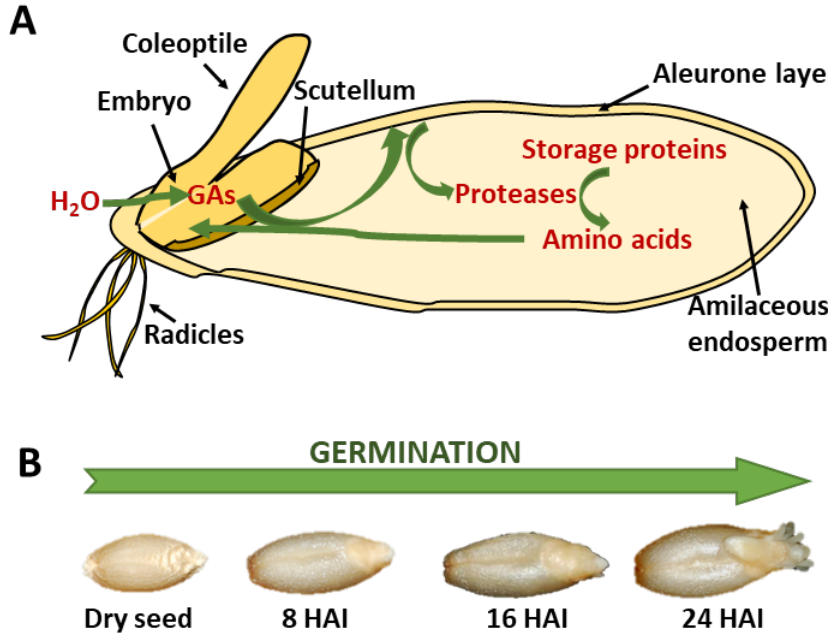
Figure 1. Cereal seed germination. ( A ) Schematic representation of the main events during storage protein remobilization in cereal seeds. ( B ) Photographs of the germination process of barley grains. HAI, hours after imbibition.